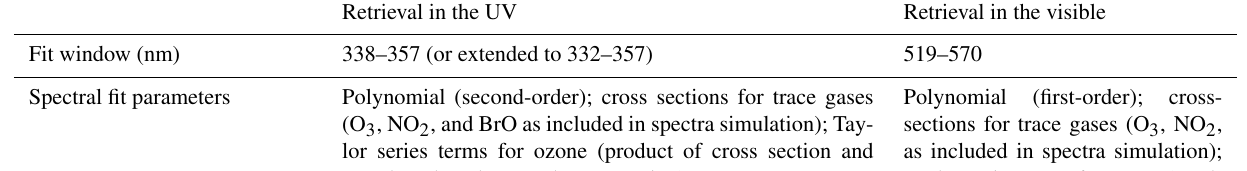
Polynomial (first-order); cross- sections for trace gases (O 3 , NO 2 , as included in spectra simulation); Taylor series terms for ozone (prod- uct of cross section and wavelength and squared cross section)